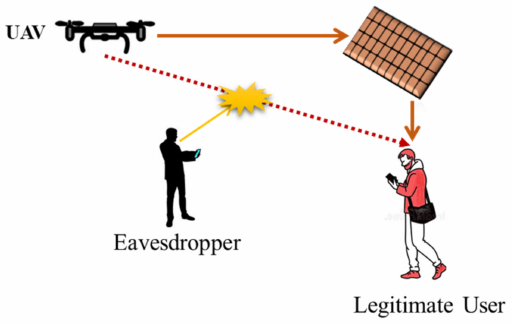
Figure 12. An IRS-assisted UAV system in the presence of